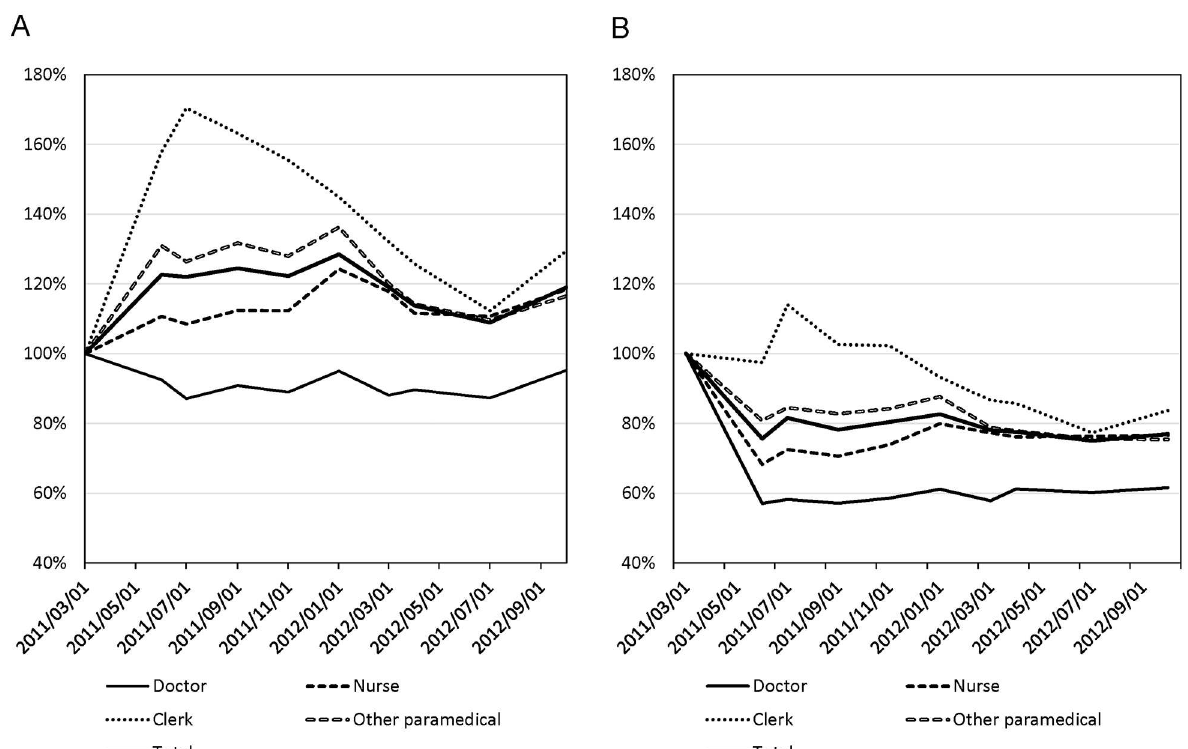
Fig 3. The % change in the estimated workload of staff members. The numbers of outpatients (A) and inpatients (B) were divided by the number of staff members.